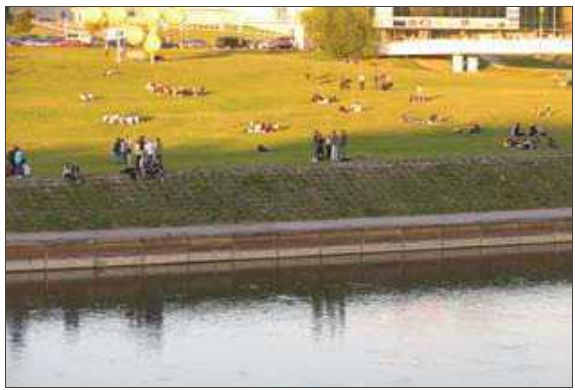
(archit. Zaha hadid grupės vizualizacija) Fig. 13. Vision of Guggenheim-hermitage Museum in Vilnius (visualization of arch. Zaha hadid group)